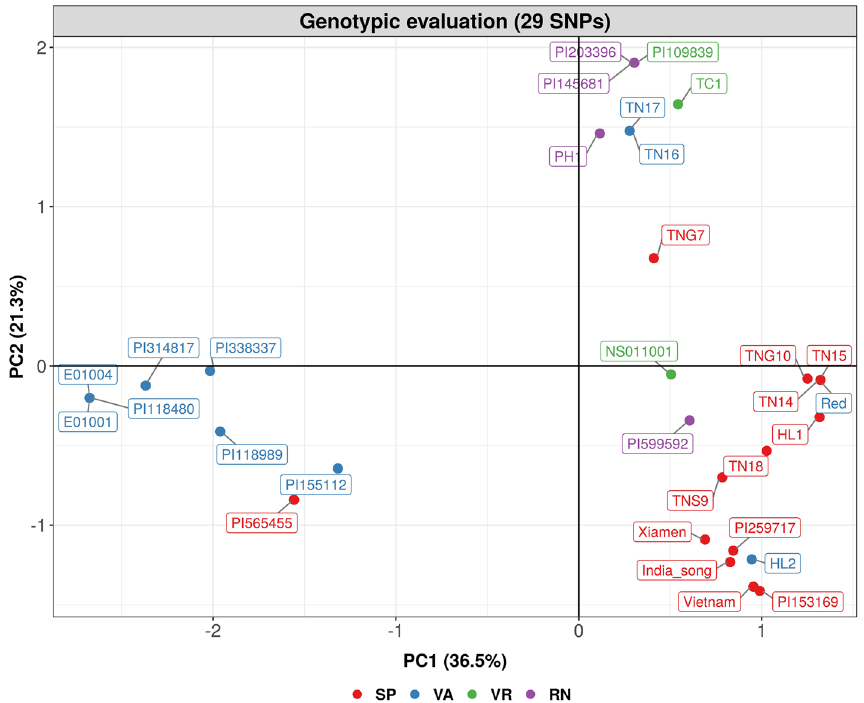
Figure 3. Principal component analysis (PCA) of the 31 accessions based on 29 single nucleotide polymorphisms (SNPs). 31 accessions were visualized by 4 market types, Spanish (SP), Valencia (VA), Virginia (VR), Runner